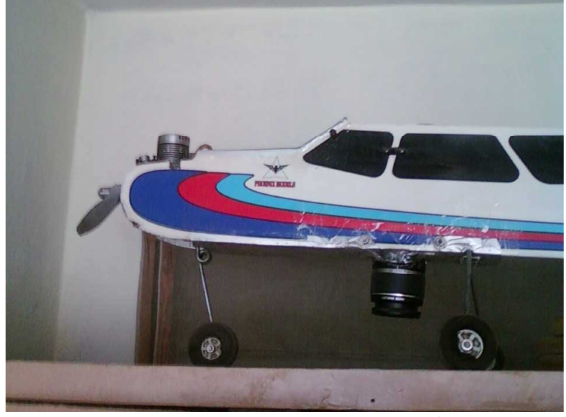
Figure 5 Camera on Model Aircraft